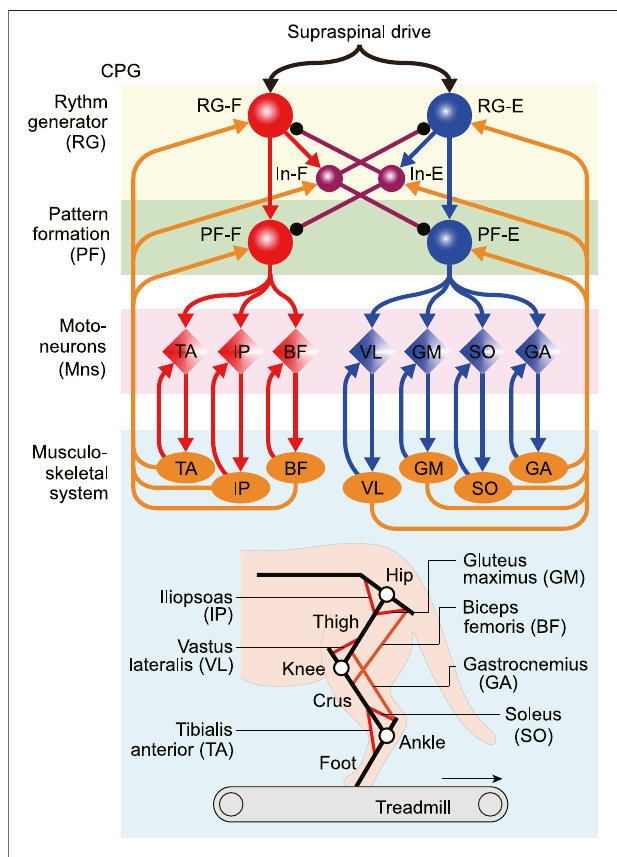
FIGURE1| Neuromusculoskeletalmodelofacathindlimbcomposedof a neural network and a musculoskeletal model. The neural network model consistsofatwo-levelcentral pattern generator (CPG)withrhythm generating (RG) and pattern formation (PF) circuits and motoneurons (Mns). This network generates motor commands through Mns and receives afferent feedback signals from the musculoskeletal model (orange arrows). The musculoskeletal model, which consists of three rigid links (black lines) and seven muscles (red and orange lines), walks on a treadmill.